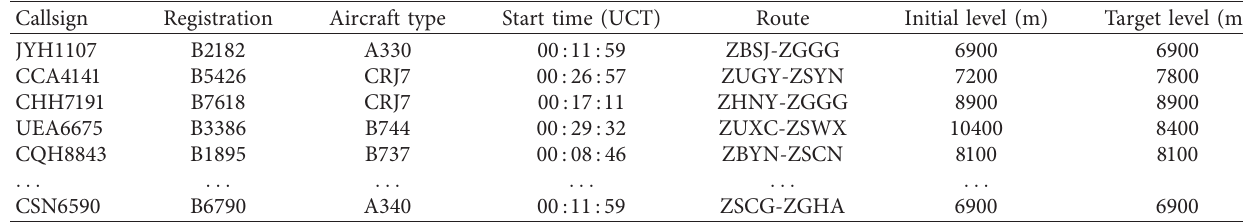
Table 2: The data form of the flight plan in a scenario